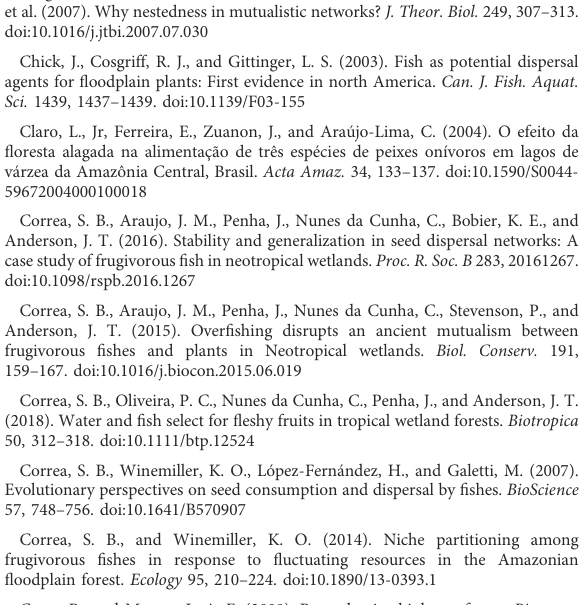
Figueiredo, D. M., and Salomão, F. X. T. (2009). Bacia do rio Cuiabá: uma abordagemsocioambiental .Cuiabá:Entrelinhas/EditoradaUniversidadeFederalde Mato